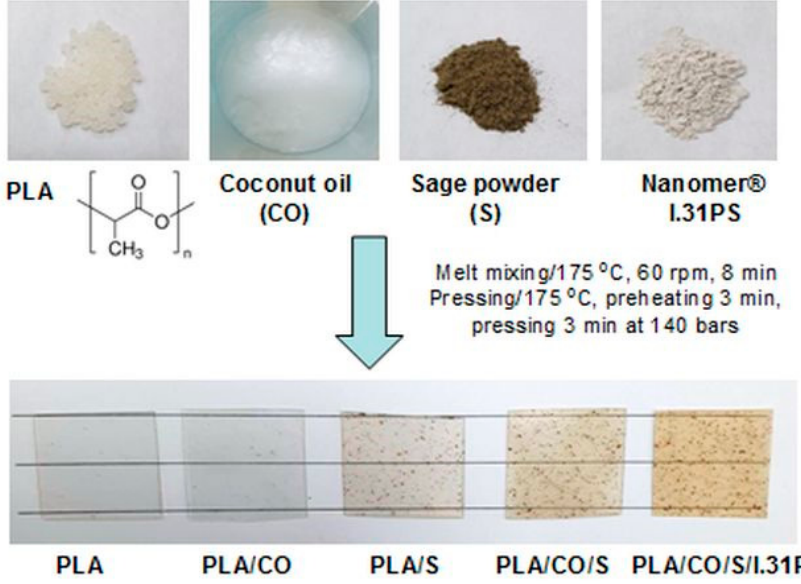
Figure 12. Schematic representation of the developed biocomposites and the visual aspects of the resulting films . resulting